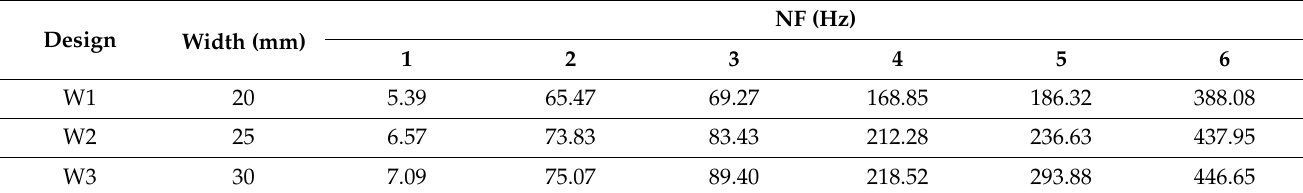
Table 4. First six NFs of a main cantilever beam with varying width (length = 200 mm). Design